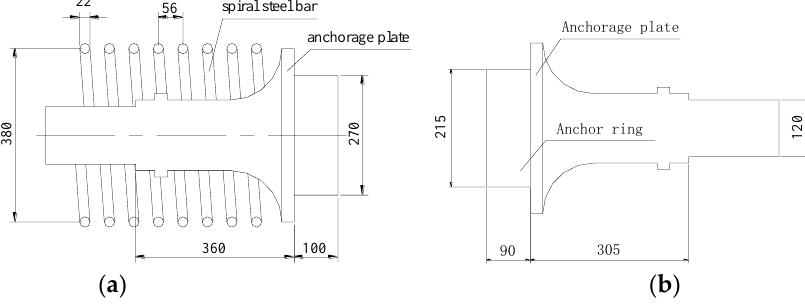
Figure 8. Anchorage devices: ( a ) YM15-31; and ( b ) YM15-19 (unit: mm).